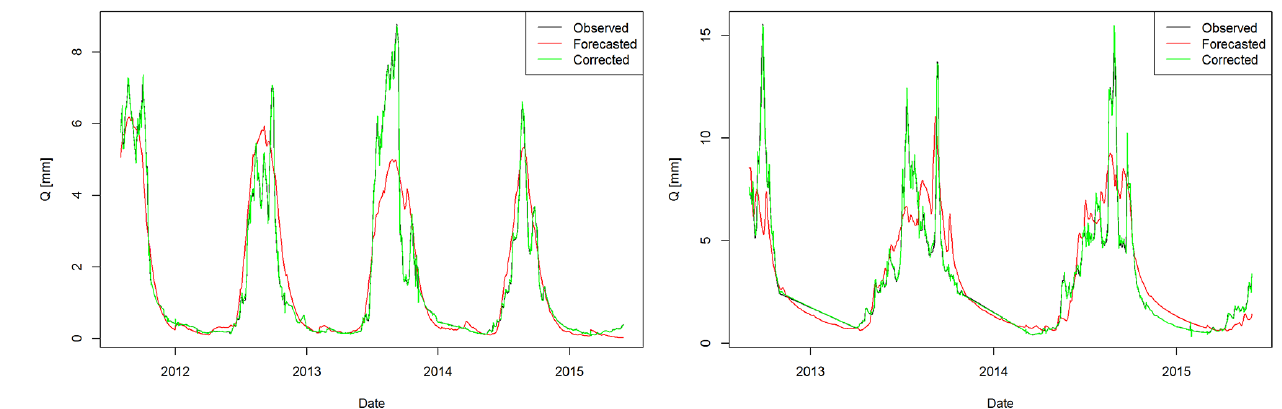
Figure 4. Observed and simulated discharge of with ARMA correction (Ganges-left and